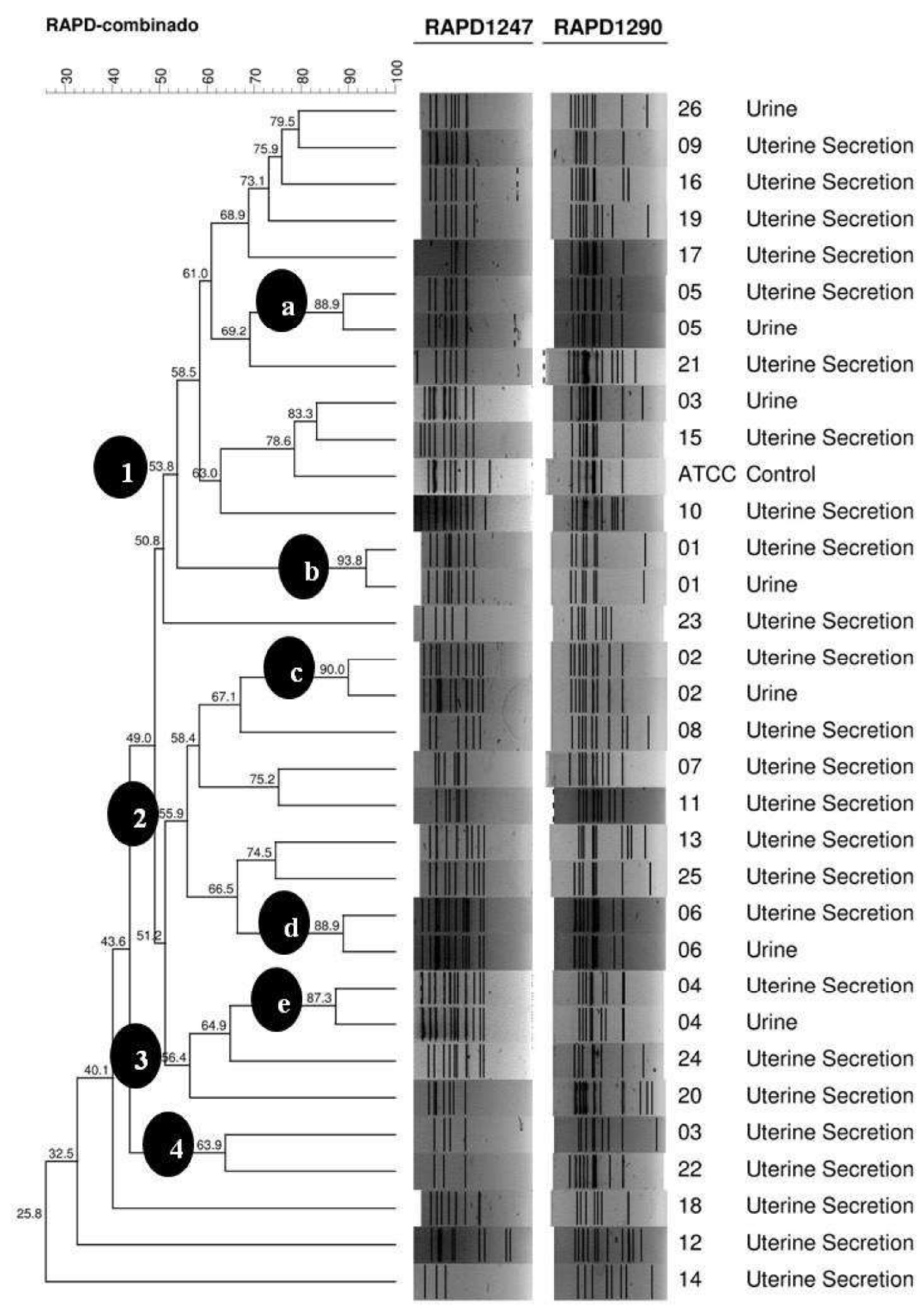
Figure 1. Dendrogram of 32 E. coli isolates originated from female dogs with pyometra Uberlândia— MG, by RAPD-PCR with primers 1247 and 1290, using the average of experiments with a tolerance of 1.5% and UPGMA method with optimisation of 85% at GelCompar II program, Sint-Martens-Latem, Belgium. Profile 1—a group with 53.8% homology, consisting of two clusters (a and b) with 88.9% and 93.8% of similarity, respectively. Profile 2—a group with 55.9% homology, consisting of two clusters (c and d) with 90.0% and 88.9% similarity, respectively. Profile 3—a group with 56.4% homology, composed of the cluster (e) with 87.3% similarity. Profile 4—a group with 63.9% homology.